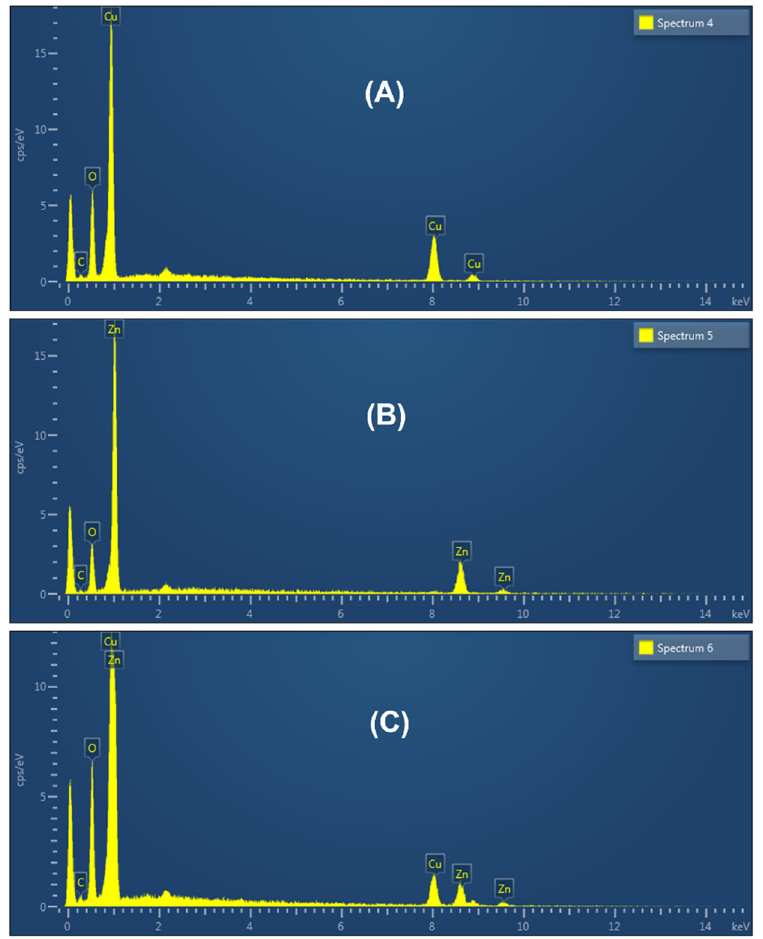
Figure 1. EDS results of ( A ) ZnO, ( B ) CuO Nps and ( C ) ZnO/CuO nanocomposite.